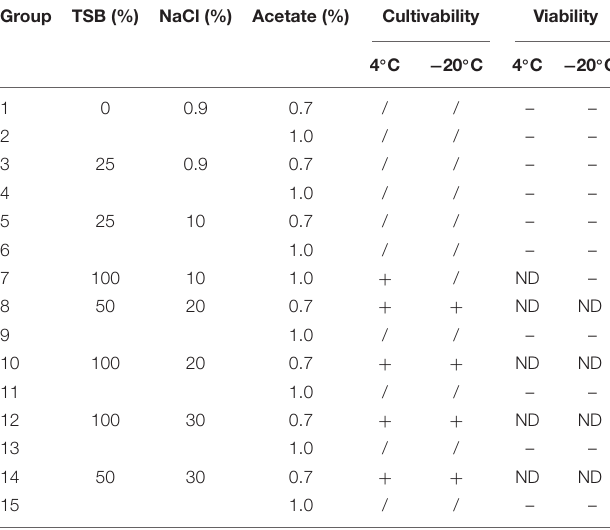
TABLE 6 | Inhibition of acidity in the formation of VBNC state of Salmonella.